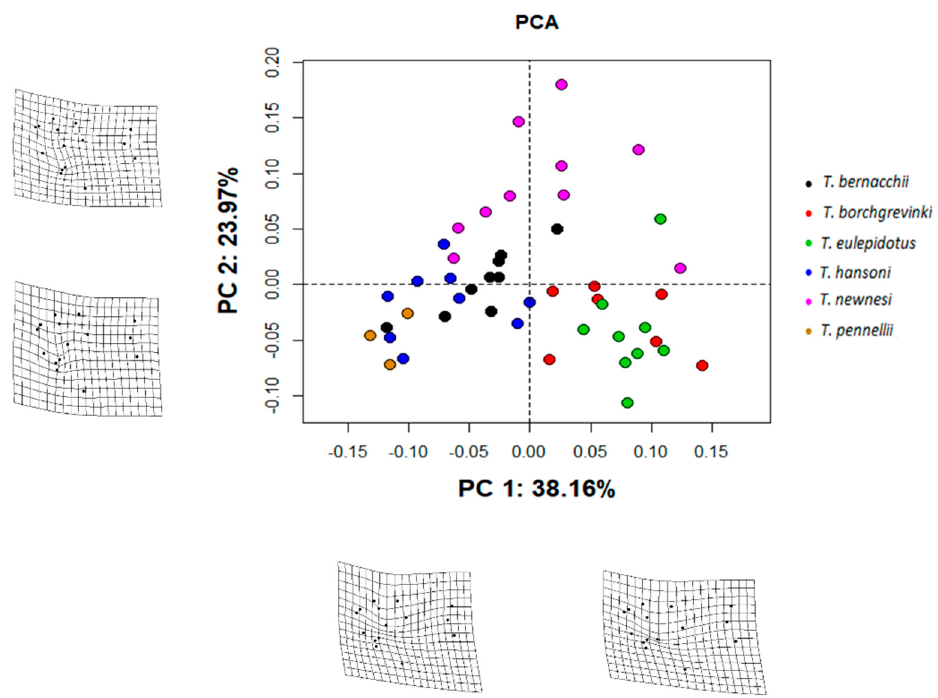
Figure 5. PCA plot obtained from geometric morphometric analysis . The thin-plate spline (TPS) transformations of the landmark positions represent the extreme transformations of the head shape measurements along the axes of the PCA, highlighting where major variations occur.